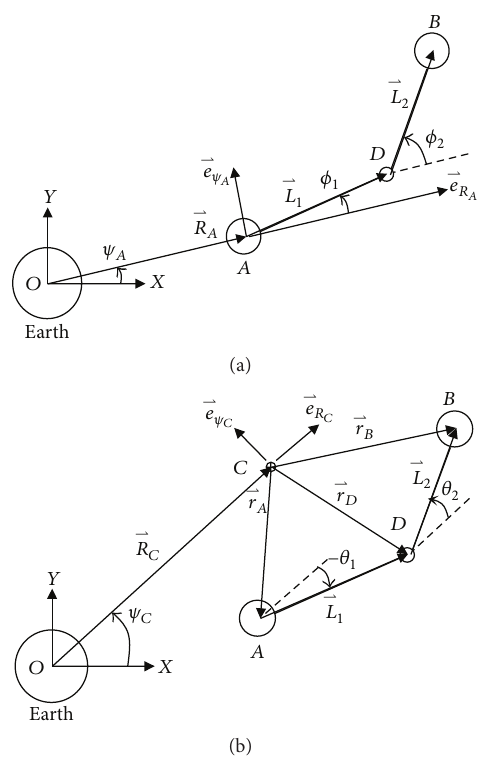
Figure 2: Simplified tethered satellite systems based on (a) point 𝐴 and (b) point 𝐶